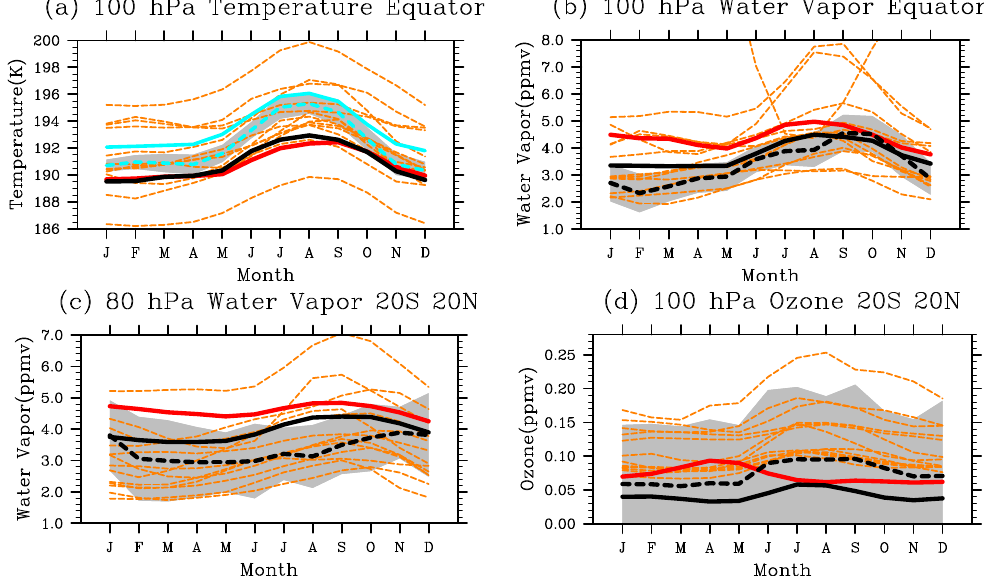
Fig. 6. Zonal tropical climatologies with “observations”, ERA-40 (cyan line), ERA-Interim (dashed cyan line, ± 1 σ 1989–2001), and HALOE observations (dashed black line, ± 1 σ , 1992–2001): (a) temperature at Equator 100hPa; (b) H 2 O at Equator 100hPa; (c) H 2 O at 20 ◦ S–20 ◦ N 80hPa; and (d) O 3 at 20 ◦ S–20 ◦ N 100hPa. Models are also shown, CNRM-ACM (red line), CNRM-CCM (black line), and CCMVal-2 REF-B1 models (dashed orange lines). Note that in the second row, ± 3 σ is shaded, as in SPARC (2010) Figs. 7.9 and 7.10.